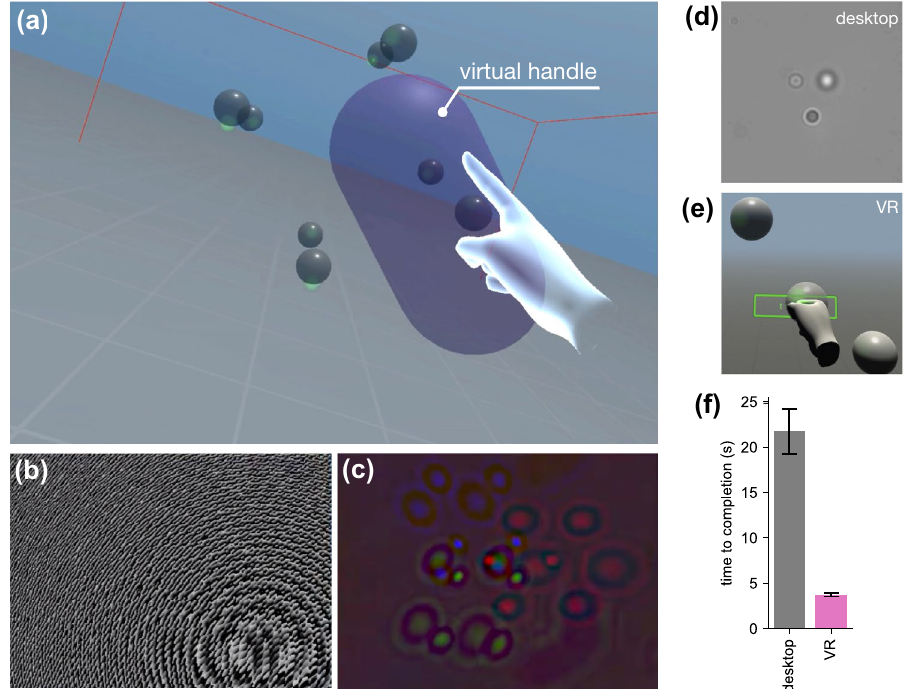
Figure 4. ( a ) Eight silica microspheres of 2 µ m diameter are interactively arranged on the vertices of a cube and then rigidly translated and rotated through a virtual global handle in purple color. ( b ) The optimized phase mask that is displayed on the SLM to generate the trap arrangement in ( a ). ( c ) RGB hologram recorded by the camera and processed in real-time to obtain the scene in ( a ) as described in Fig. 2. See also Supplementary Video 2. ( d ) User microassembly task using the standard desktop interface. ( e ) User microassembly task through our VR interface. ( f ) Barplots represent the sample mean of time to completion using the two interfaces (error bars are standard errors). This figure was made using Unity 28 and Matplotlib 38